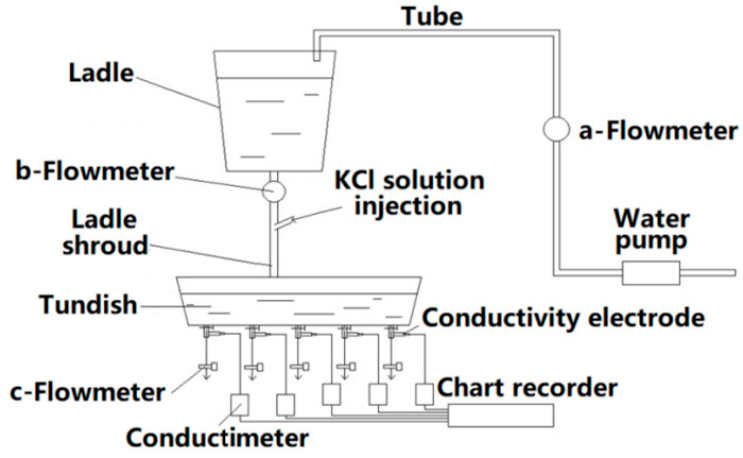
Figure 2. Experiment apparatus.